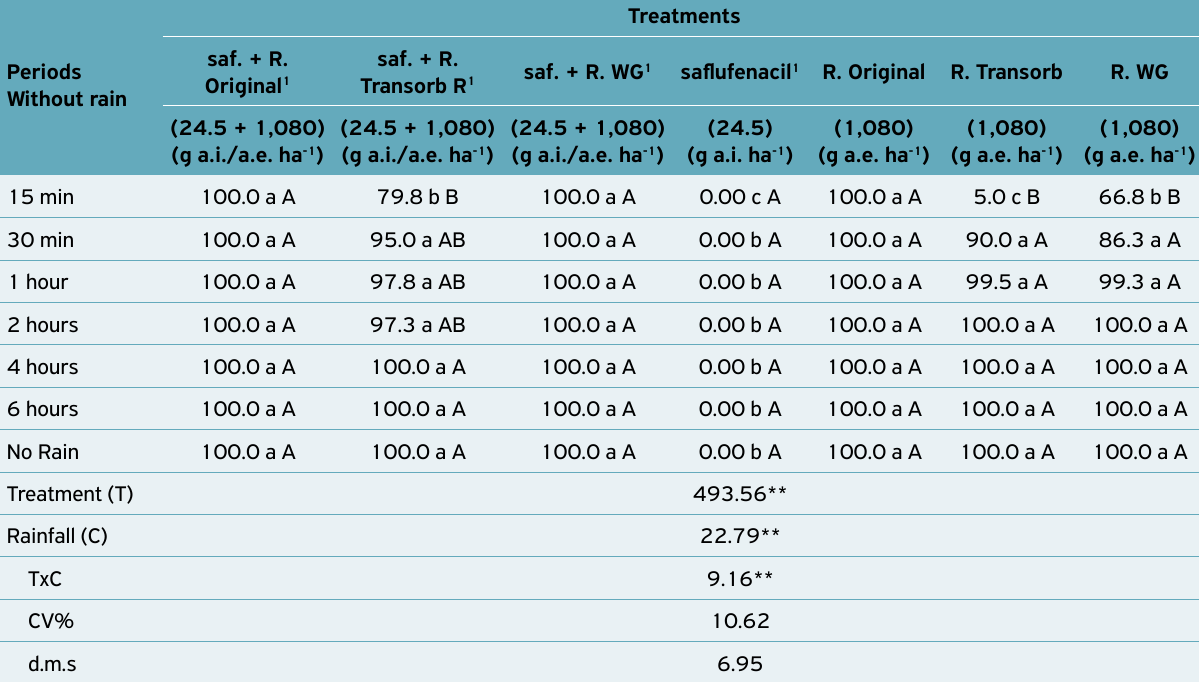
Table 4. Mean values for percentage of control of Brachiaria decumbens at 21 DAA obtained by the unfolding of degrees of freedom of the interaction between herbicides and periods without rain after the application of herbicides.